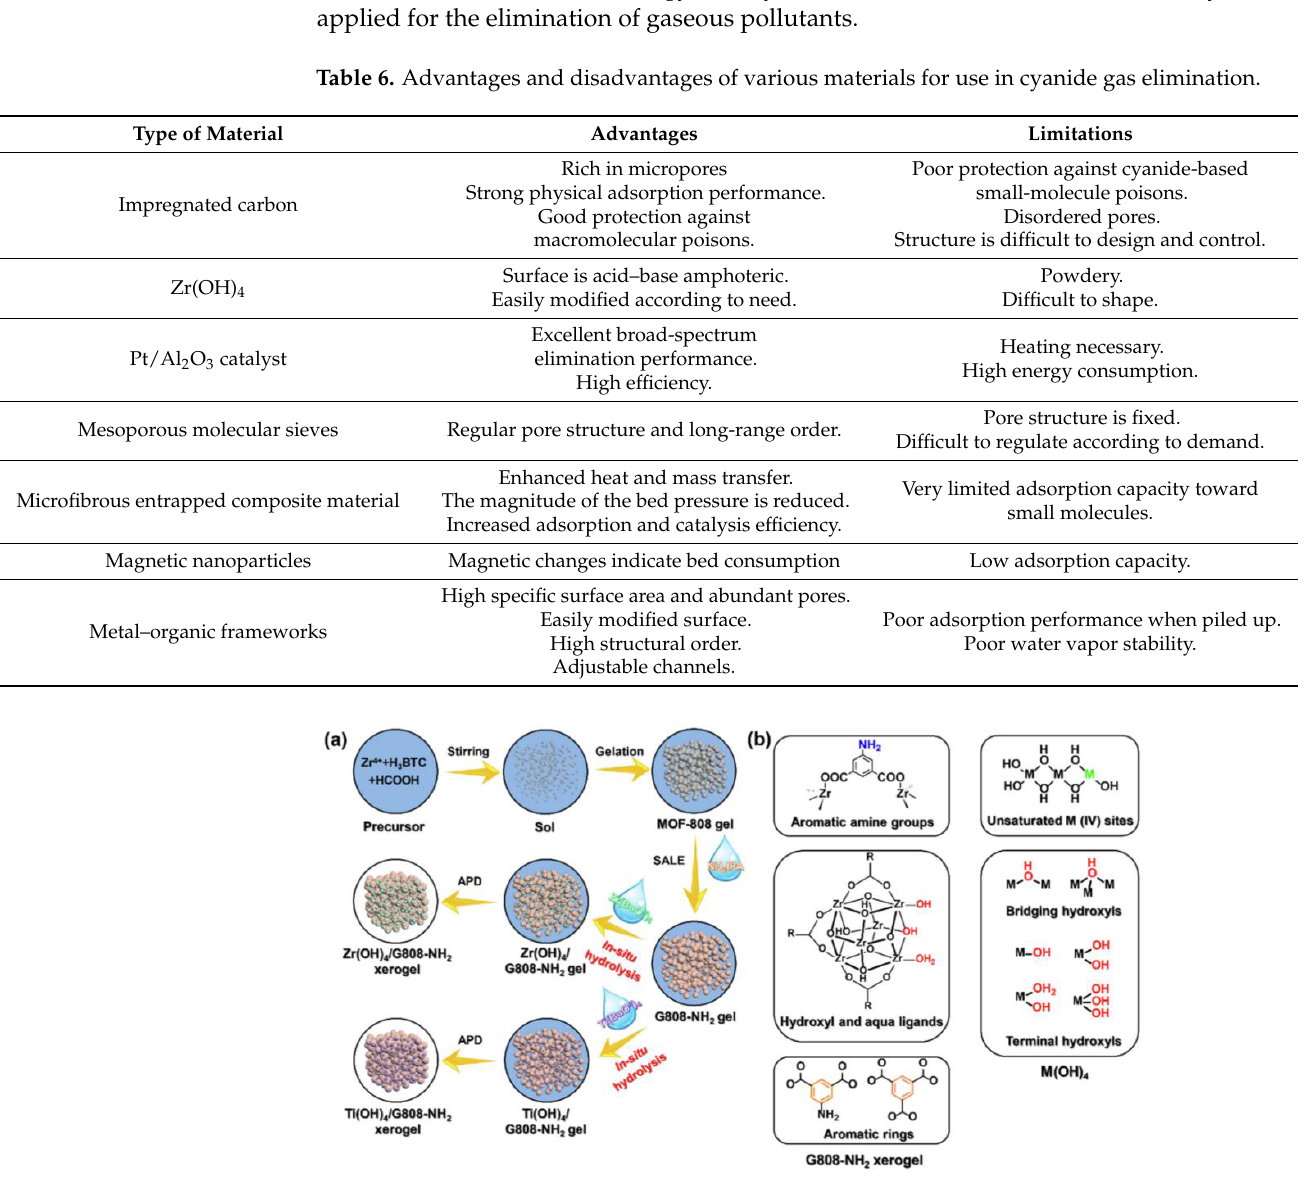
Figure 7. ( a ) Scheme for the synthesis of M(OH)4/G808–NH 2 (M = Zr, Ti) xerogel composites via an in situ hydrolysis strategy; ( b ) potential sites for irreversible adsorption for poisonous species [81]. Table 6. Advantages and disadvantages of various materials for use in cyanide gas elimination.